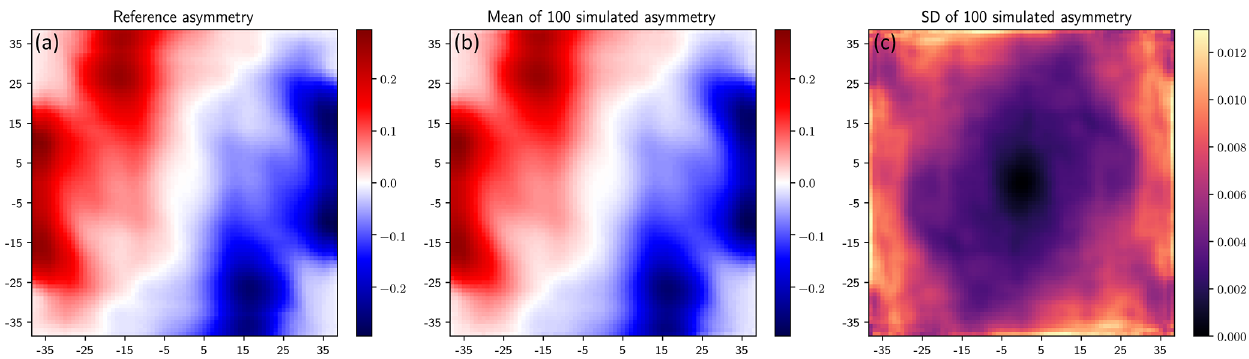
Figure 11. (a) Reference asymmetry function. (b, c) Mean and standard deviation of 100 simulated asymmetry functions. Unit: